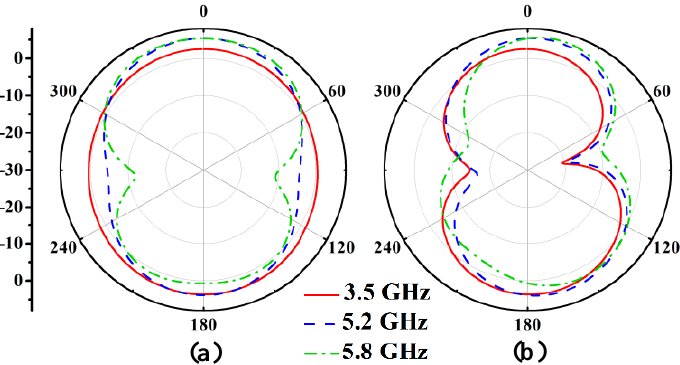
Figure 5. Simulated reflection coefficient of the STPA as a function of microstrip-line length L 4 .